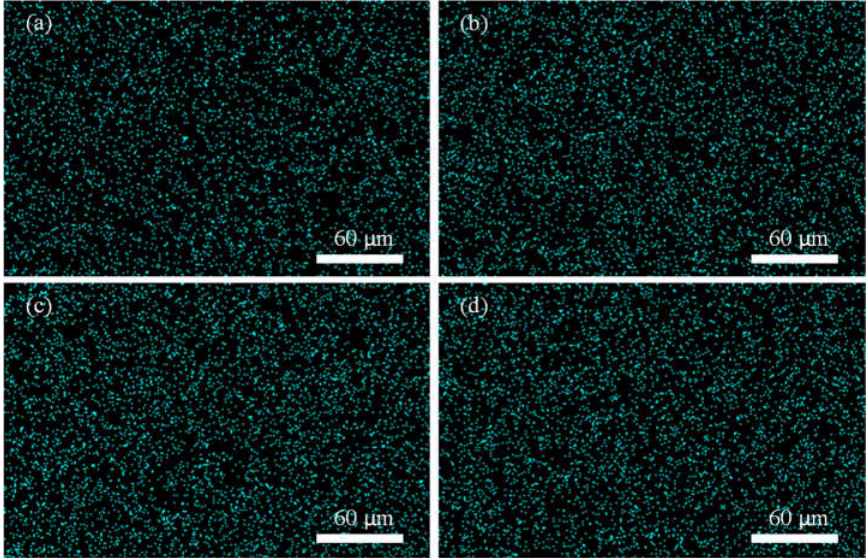
Figure 4. Mapping of silicon in PES/modified silica MMMs ( a ) S11 ( b ) S12 ( c ) S13 and ( d ) S14.